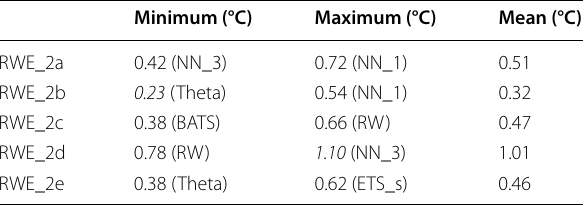
The minimum of the minimum values and the maximum of the maximum values are in italic